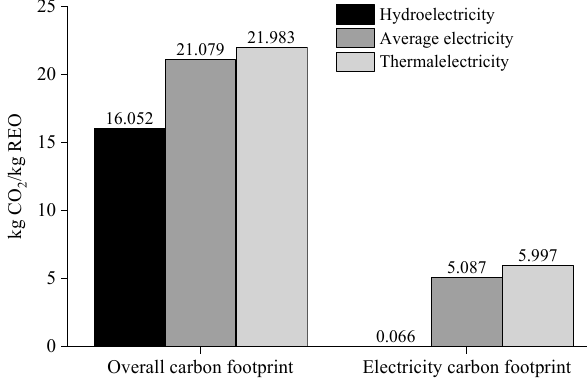
Figure 7. Impact of clean energy use on carbon footprint.